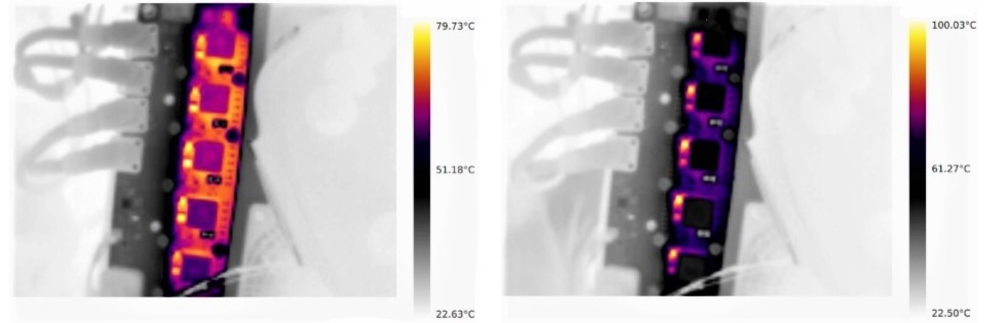
Figure 15. Temperatures of the mosfets at I in = 45 A for the non-synchronous operation mode ( right ) and for the synchronous operation mode ( left ) obtained with a thermal